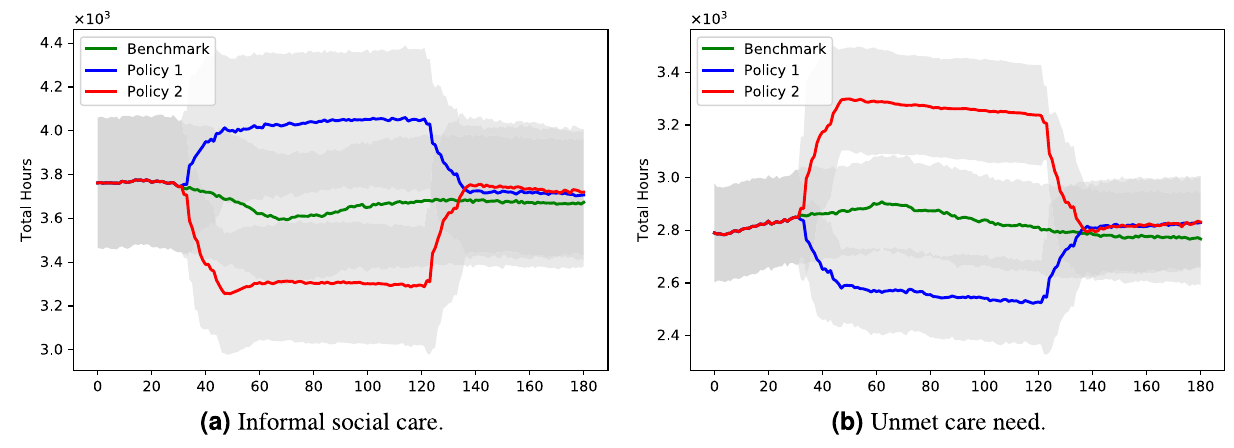
Figure 4. Policy comparison: care dynamics.